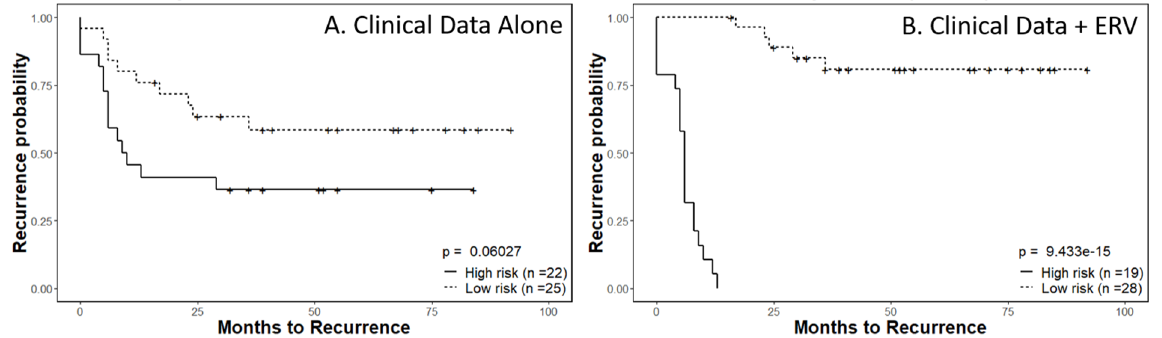
Figure 5. Kaplan–Meier survival plots of recurrence risk for cervical cancer patients. Kaplan–Meier survival analysis of recurrence using low-risk or high-risk models based on ( A ) clinical factors only ( p = 0.06027) compared to ( B ) a combination of clinical factors and 67-ERV RNA panel expression levels ( p = 9.433 × 10 − 15 ). The analysis was performed on a test set of n = 47 patients selected from the total cohort of 63 patients.